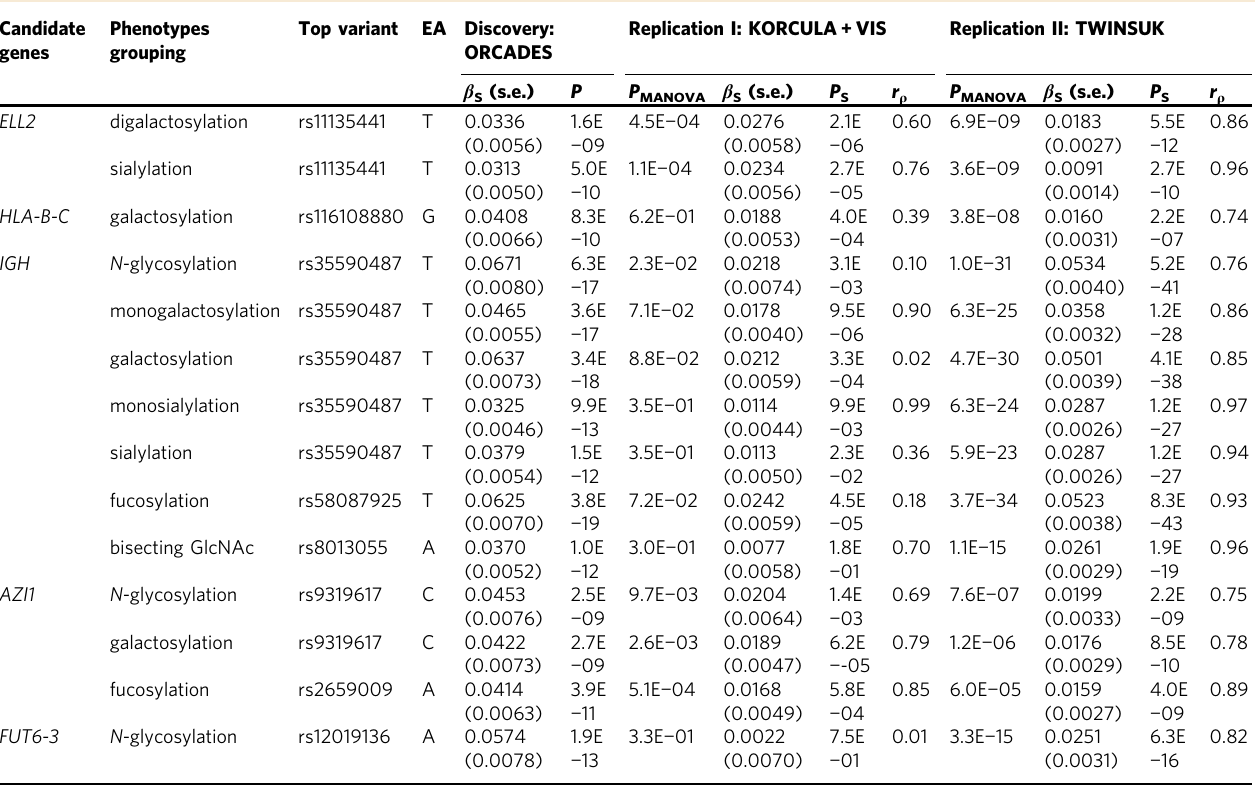
Table 1 Novel loci detected via multivariate GWAS for IgG N -glycosylation